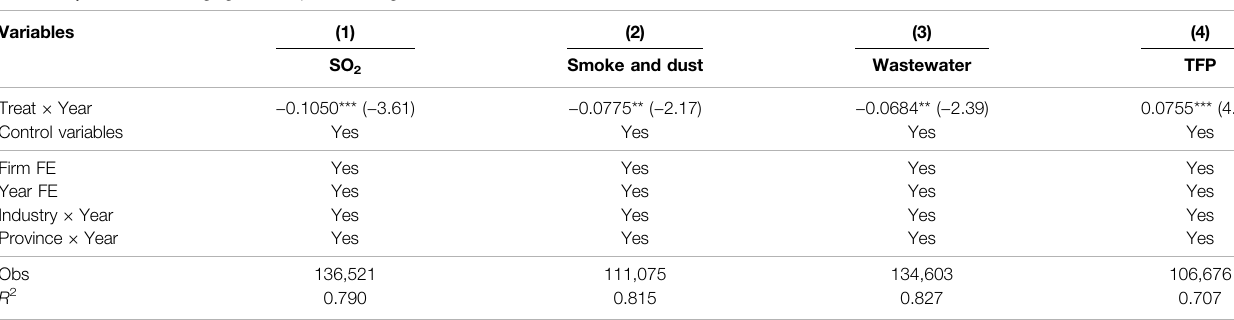
TABLE 8 | Results of changing the sample time